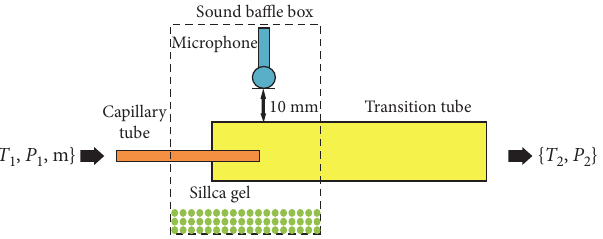
Figure 5: Setup of the sound baffle box around the capillary tube